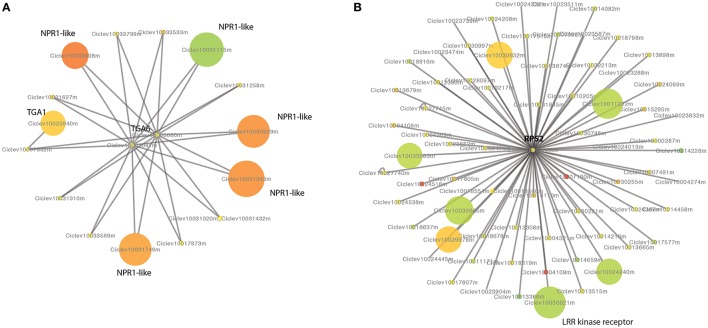
Protein-protein interaction network of citrus predicted based on the knowledge of IPP network of Arabidopsis. (A) Interactions between NPR1-like proteins and TGA transcription factors. (B) Proteins interacting with RPS2. The DE genes are indicated in colors, red for up-expressed and green for down-expressed in HLB tolerant “Jackson” trees compared to HLB susceptible “Marsh” trees. The size of the nodes negatively correlates to the FDR and the color correlates to the log2 fold ratio.